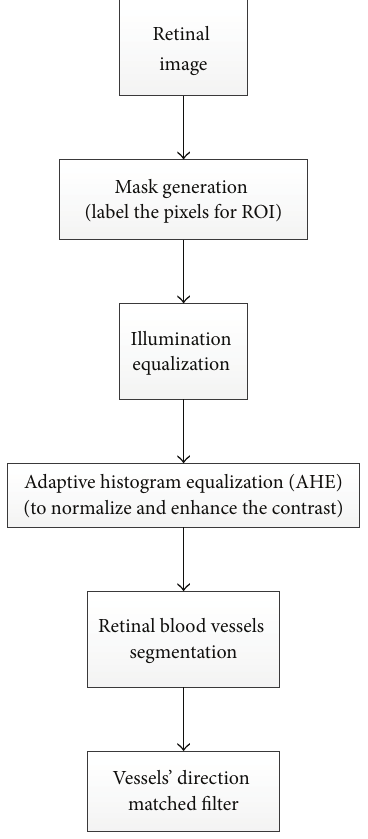
Figure 21: Flowchart for algorithm proposed in [17].